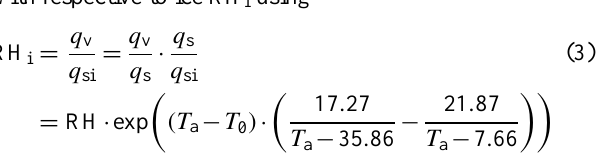
at Baker Lake. In comparison, the correlation coefficient is the lowest for the relative humidity with respect to ice. Nev- ertheless, the agreement of the mean value and the range is still